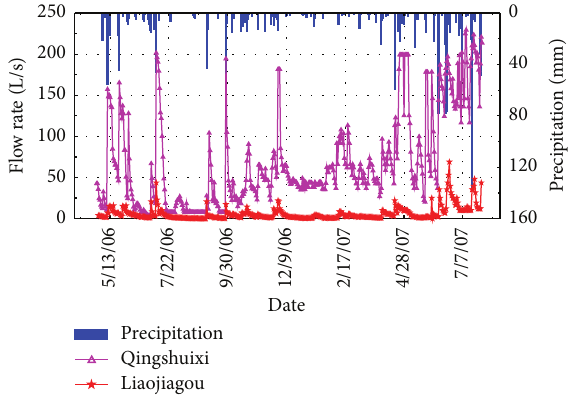
Figure 5: Hydrographs of Qingshuixi and Liaojiagou.